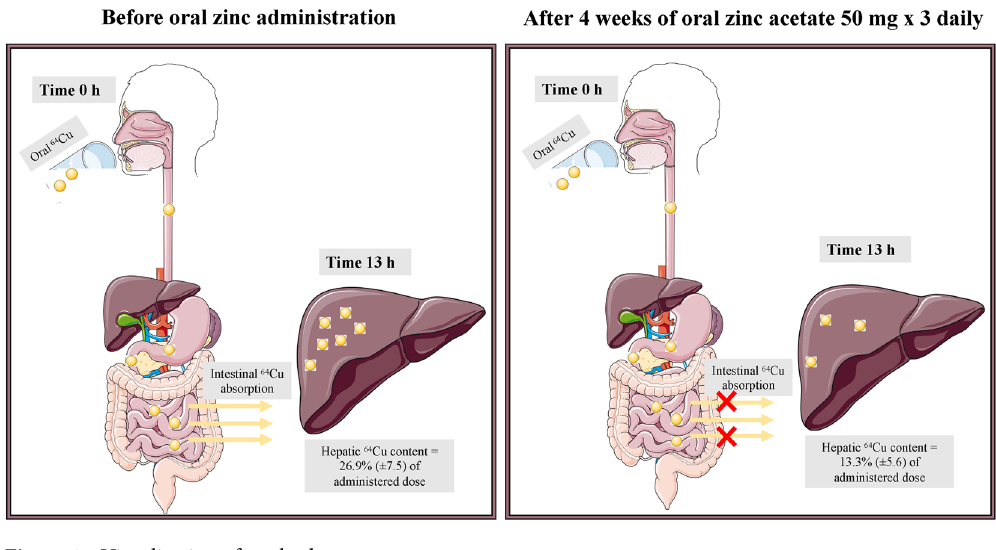
Figure 1. Visualization of